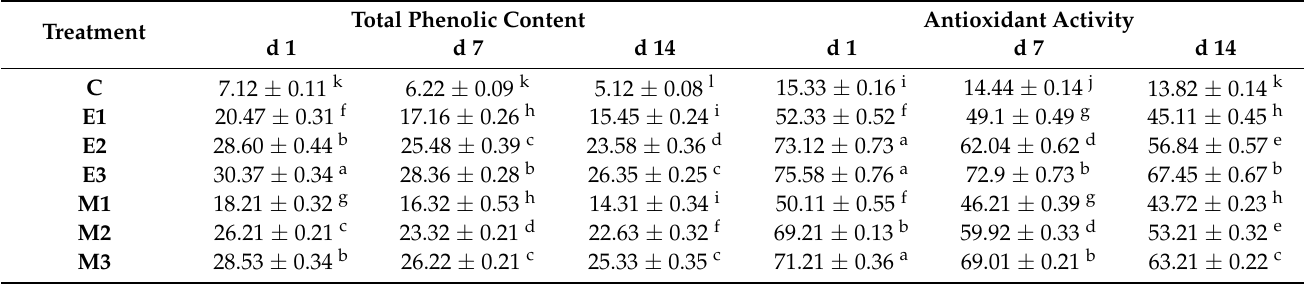
Table 4. Total phenols ( µ g Gallic acid equivalent/g sample) & Antioxidant potential measured by DPPH radical scaveng- ing